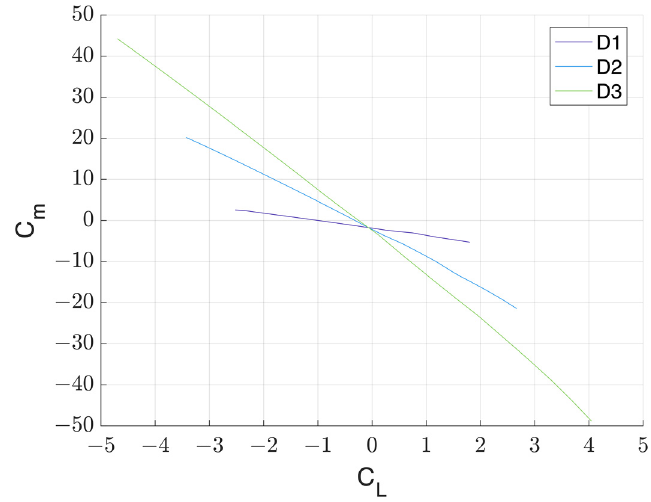
Figure 6. Variation of the pitch moment with respect to the lift.